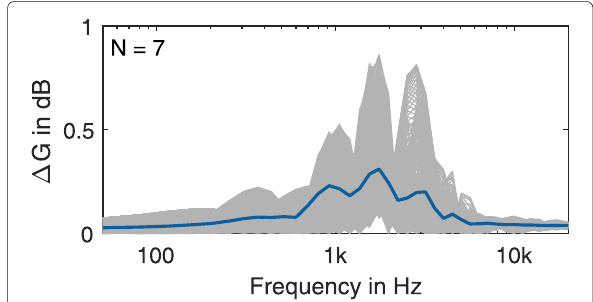
Fig. 3 Working Example 1: Left-ear absolute energetic difference (cid:4) G in auditory gammatone filter bands between BRTFs resulting from the SOFiA (reference) and the SMATBIN filter processing ( K = 2048 taps) for 360 head orientations in the horizontal plane (1° steps from 0° to 360°) and a single broadband plane wave incident from the front ( φ = 0°, θ = 90°) on a rigid sphere array with a Lebedev sampling scheme of order N = 7. The gray lines show the difference for each individual head orientation, the blue line shows the difference averaged across all head orientations